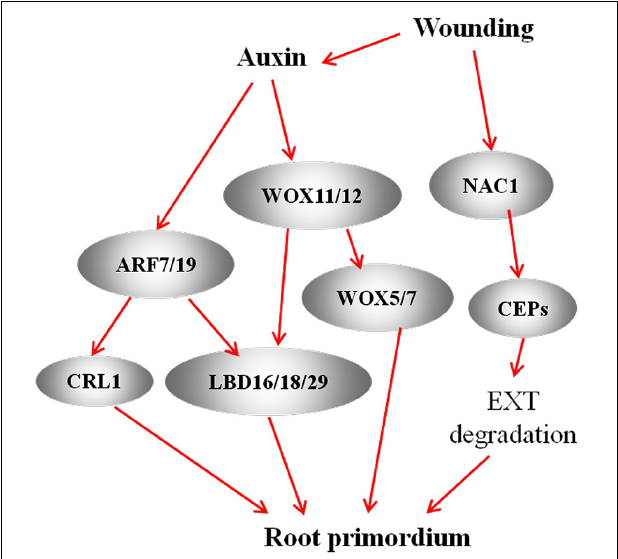
FIGURE 2 | A model of interaction among WOXs, LBDs, and ARFs regulates the formation of AR primordia during AR formation. In the AR model of Arabidopsis seedlings, ARF7/19 activate LBD16/18/29 expression to promote AR formation (Lee et al., 2019). In the rice model, ARFs target CRL1 to regulate AR (Inukai et al., 2005). During de novo AR formation in Arabidopsis leaf explants, wounding-induced auxin activate the expression of WOX11 and WOX12 , which upregulate LBD16 and LBD29 (Liu et al., 2014) and directly activate WOX5 and WOX7 to promote AR (Hu and Xu, 2016). In de novo AR model in leaf explant of Arabidopsis, wounding-induced the expression of NAC1 highly upregulated the expression of Cys endopeptidase-coding gene CEP1 and CEP2 . CEP plays a role in degradation of extensin (EXT) in the cell wall and thus conduces to the emergence of AR primordia (Chen et al., 2016). Red arrows represent positive